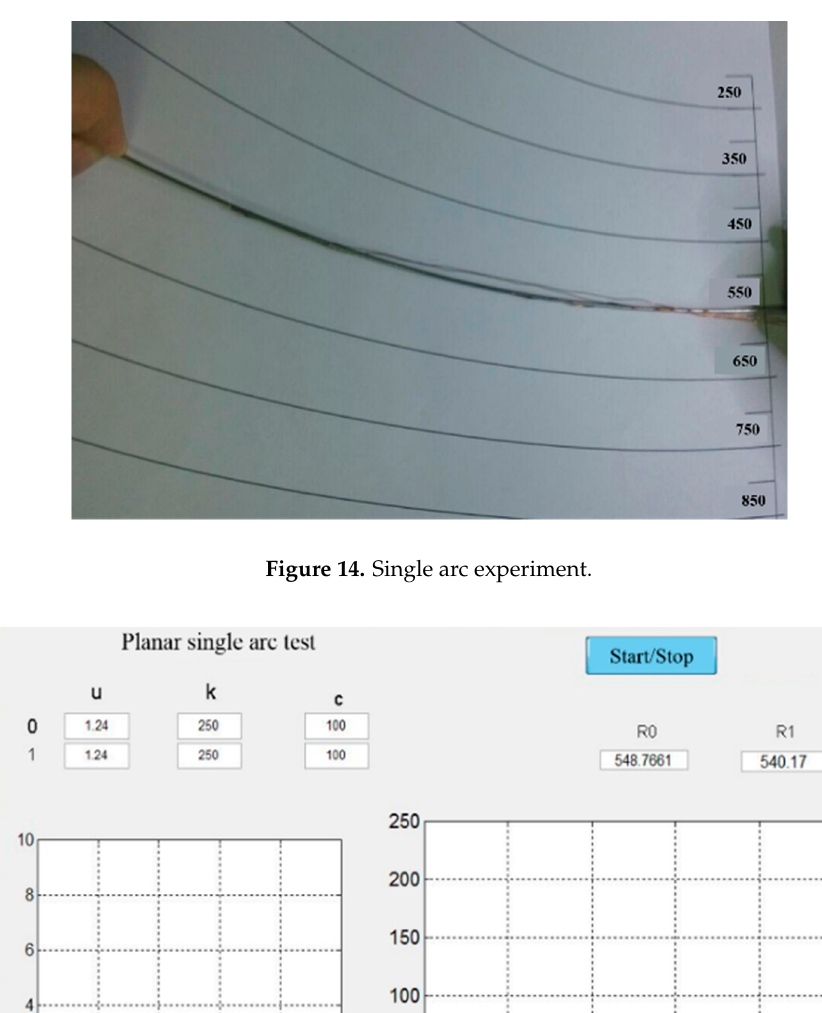
Figure 15. Experiment results.